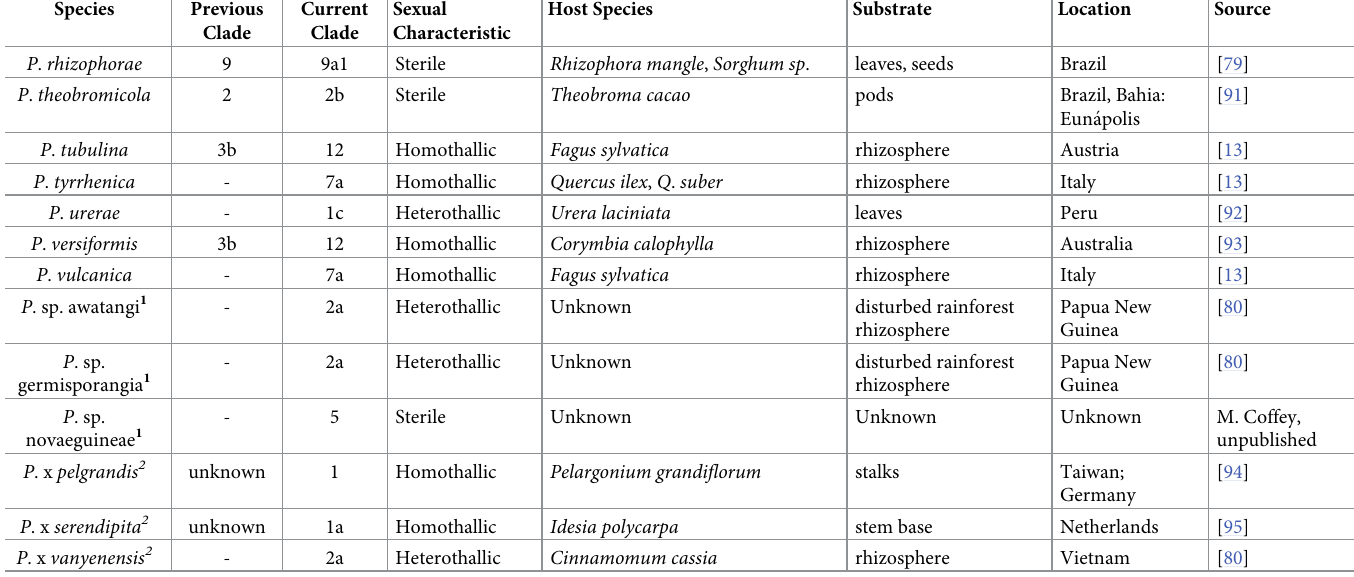
genotype. Above the threshold was another peak in the distribution of Bruvo’s distances. Pairs falling in this range of the distribution represent lineages, which are distinctly different, likely as a result of sexual recombination. In other words, these are lineages that should not be con- sidered the same genotype. This result visually confirmed the threshold genetic distance as estimated by Poppr’s cutoff prediction function. The SSR classifier was parameterized to use a cutoff threshold of a Bruvo’s distance of 0.099 in order to consider an unknown P . infestans isolate a match to a described lineage. The reference dataset for classifying genotypes consisted of 2,176 isolates of P . infestans and their corresponding microsatellite genotypes obtained from over thirty years of collecting by Jean Beagle Ristaino. The overall accuracy of the classifier was approximately 0.98, with an unweighted Kappa statistic of 0.977. Various summary statistics were also calculated for each individual class (lineage, n = 36) that isolates could be placed into (S3 Table). Some of the iso- lates included in the reference dataset had one or only a few representative genotypes. For these isolates, accuracy, precision, and other summary statistics were not calculated because there were no closely matching isolates. Many of these isolates are no longer in circulation (most of the US lineages except US-23, US-8, and US-11) or were transient. Importantly, the SSR classifier was able to identify the US genotypes from the recent past that are currently cir- culating (S3 Table). As collection of isolates continues, the classifier will continue to grow more robust with the increase in reference data. A list of all representative genotypes used to develop the classifier and their SSR profiles can be found in S4 Table. This includes several genotypes for which there were too few isolates to perform statistical testing. To evaluate the performance of the P . infestans classifier with incomplete SSR genotype data, a testing dataset was developed that included genotyped lineages which had at least 7 but no more than 11 SSR loci genotyped. Many of these isolates were from historic samples of